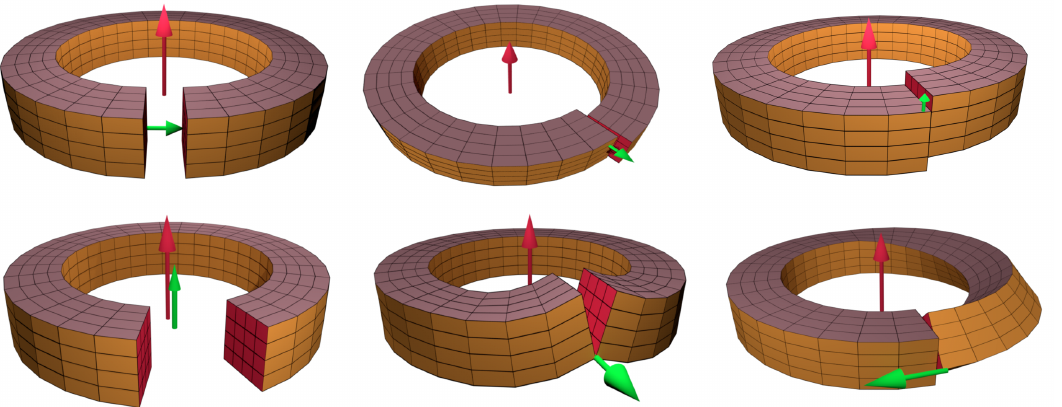
Figure 8: An overview of the different types of Dislocations and disclinations by Volterra construction. On the top row are the dislocations: the two types of edge dislocations, where the Burgers vector (in green) is perpendicular to the dislocation line (red), and the screw dislocation, where the dislocation line and Burgers vector are parallel. On the bottom row are the disclinations: the wedge disclination, where the Frank vector (in green) is parallel to the dislocation line (in red), and the two twist disclinations where the Frank vector is perpendicular to the dislocation line. After Ref. [ 94 ]